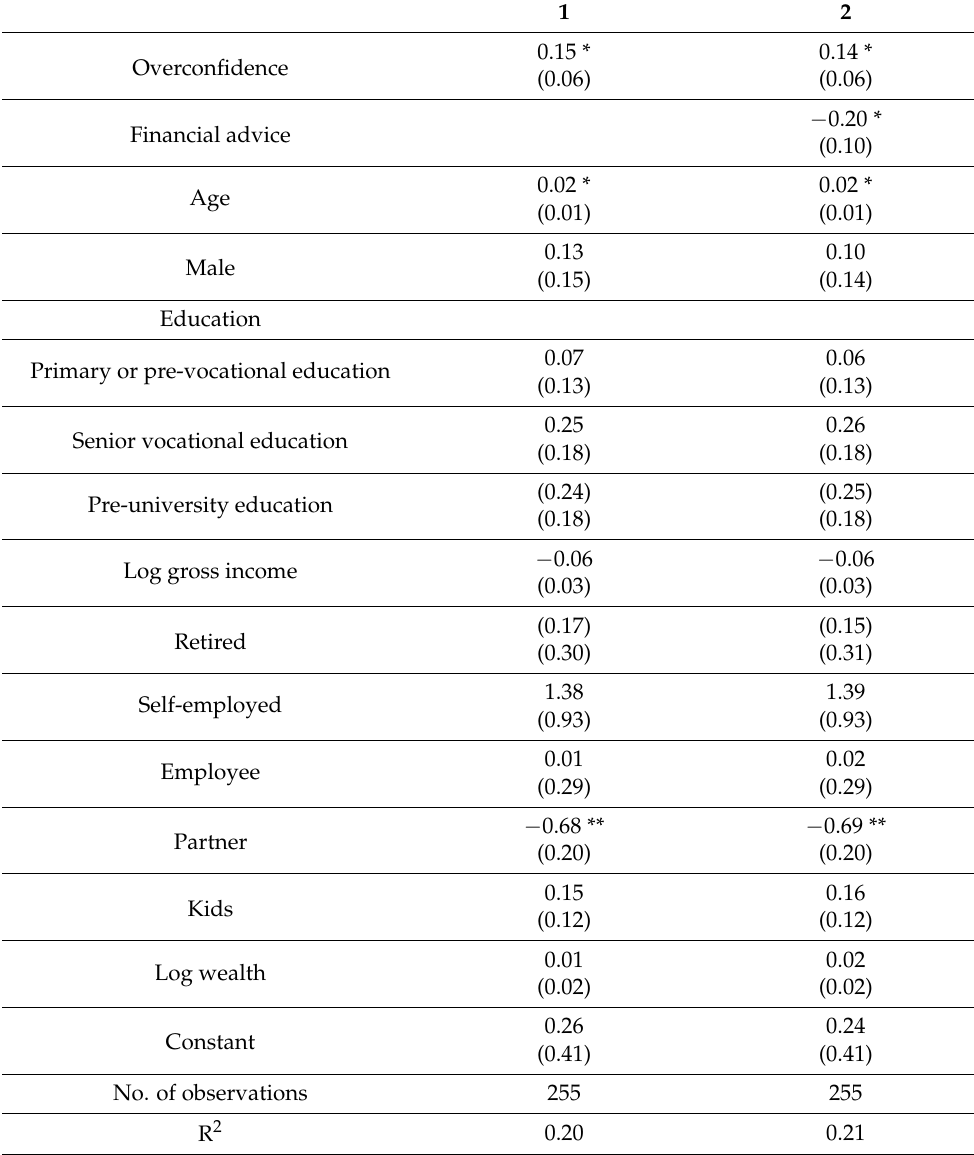
Table 3. Return Loss, Overconfidence and Financial Advice Seeking, Multivariate